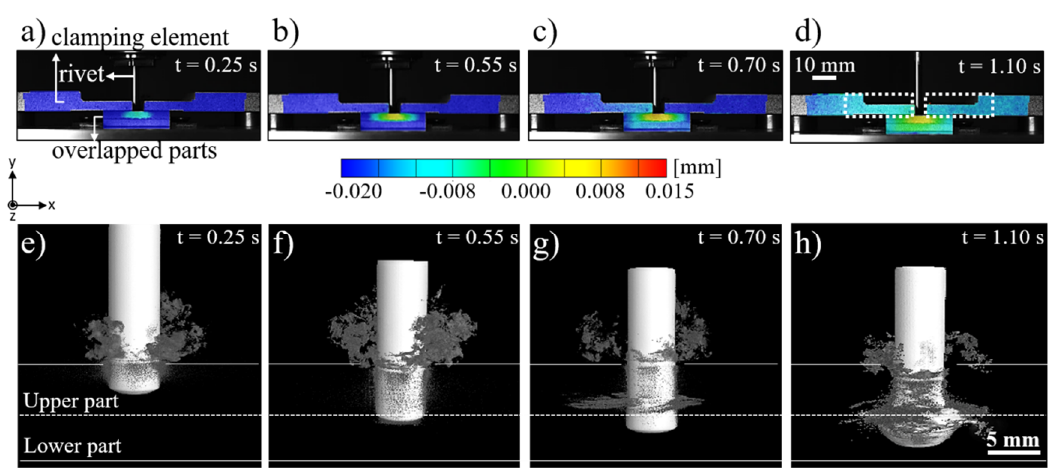
Figure 8. Evolution of the displacement distribution through the clamping system and joint parts ( a – d ) along with the joint formation ( e – h ) over the process time. (Joining parameters - RS: 15,000 rpm, FF: 15 kN, DF: 7.5 mm, CP: 0.2 MPa) .